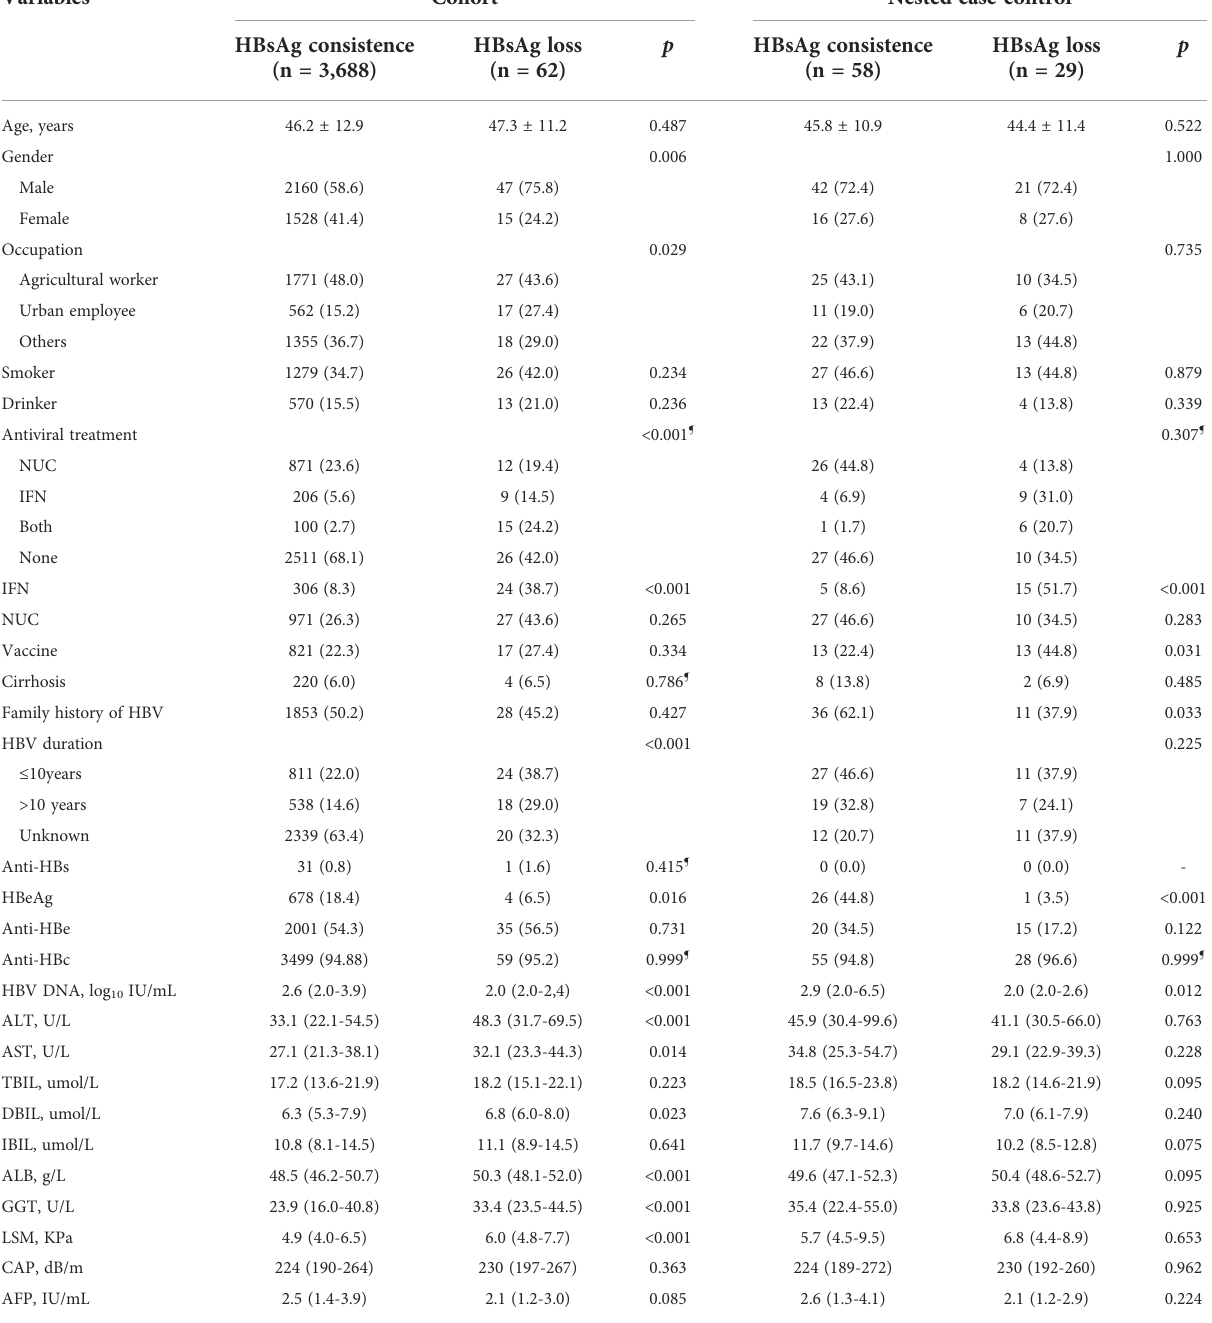
TABLE 1 Population characteristics for HBsAg consistence and HBsAg loss